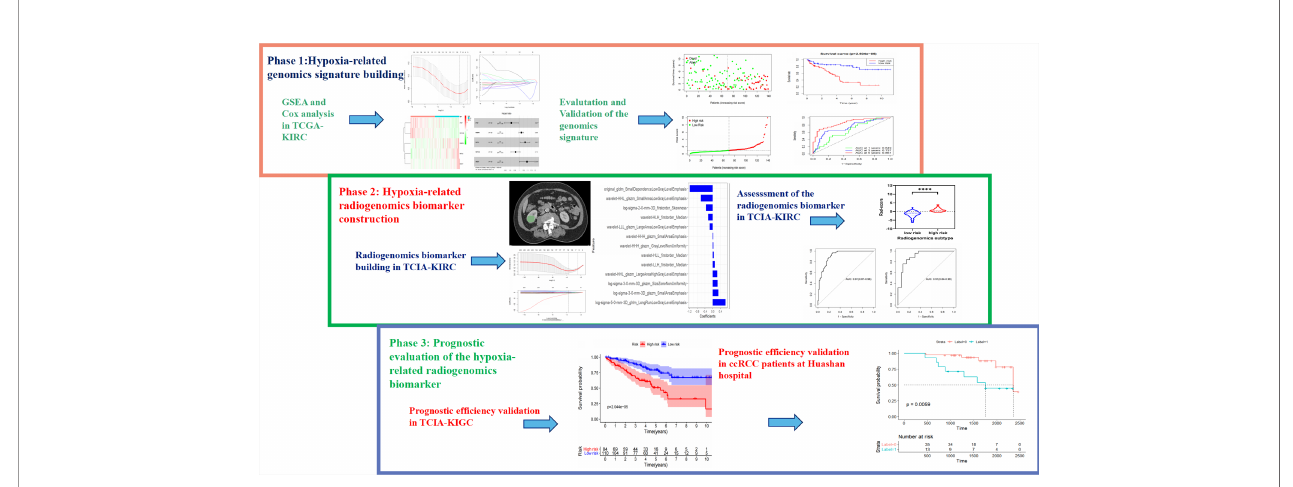
FIGURE 1 | Work fl ow of the